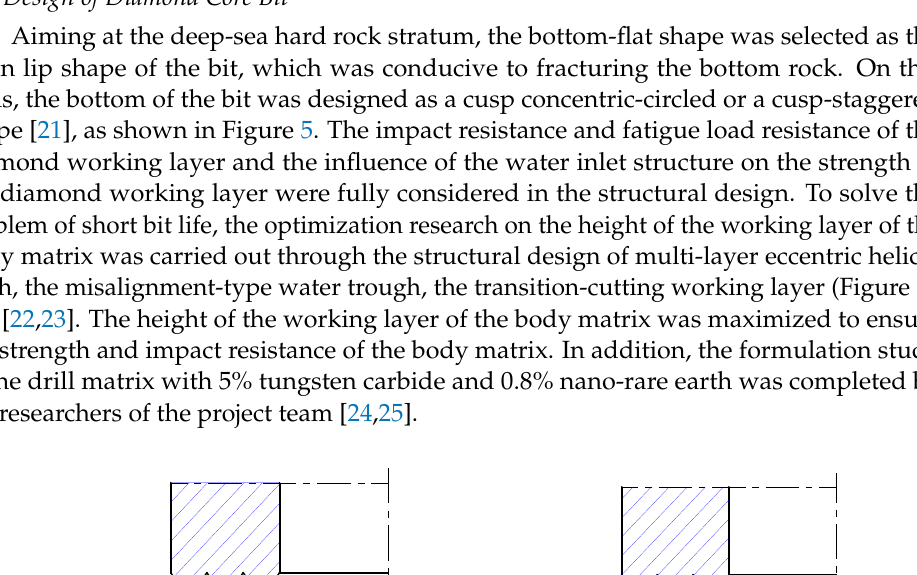
Figure 4. ( a ) Optimization of roller core bit; ( b ) Installation of the roller core bit in the sea test; ( c ) Sea test of the roller core bit.